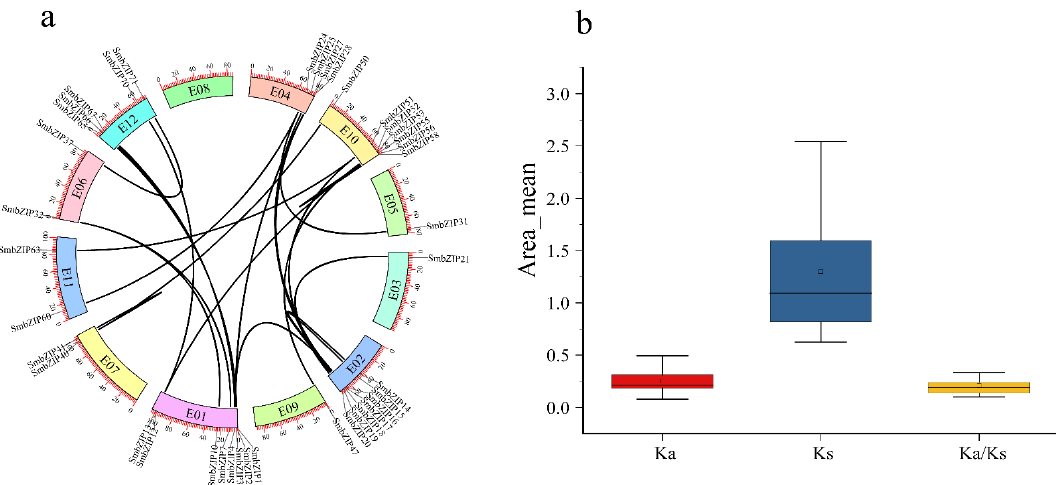
Figure 5. Genomic locations of SmbZIP genes and segmentally duplicated gene pairs in the egg- plant genome (a) and Ka , Ks , and Ka / Ks ratio of segmental duplicate genes (b). The 24 segmentally duplicated SmbZIP gene pairs are indicated by the black lines. A color box with a number inside it represents each chromosome. The box plots are exhibiting the distributions of Ka , Ks , and Ka / Ks values among paralogs. The small square and the line in the box represent average and median values of the Ka , Ks , and Ka / Ks values, respectively. Sm: Solanum melongena ; At: Arabidopsis thaliana ; Os: Oryza sativa.